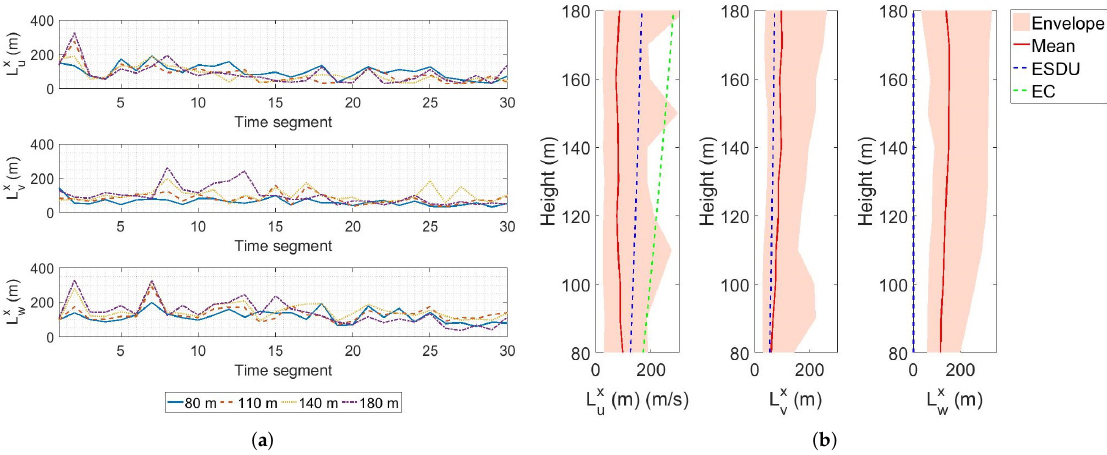
Figure 15. Wind episode 5 on 3 December 2019: ( a ) time series of along-wind turbulence integral length scales at four different heights above the ground, obtained from Doppler wind lidar measurements; ( b ) vertical profiles of turbulence integral length scales, represented by their envelope and mean, along with Eurocode (EC) and ESDU approximations denoted by dashed